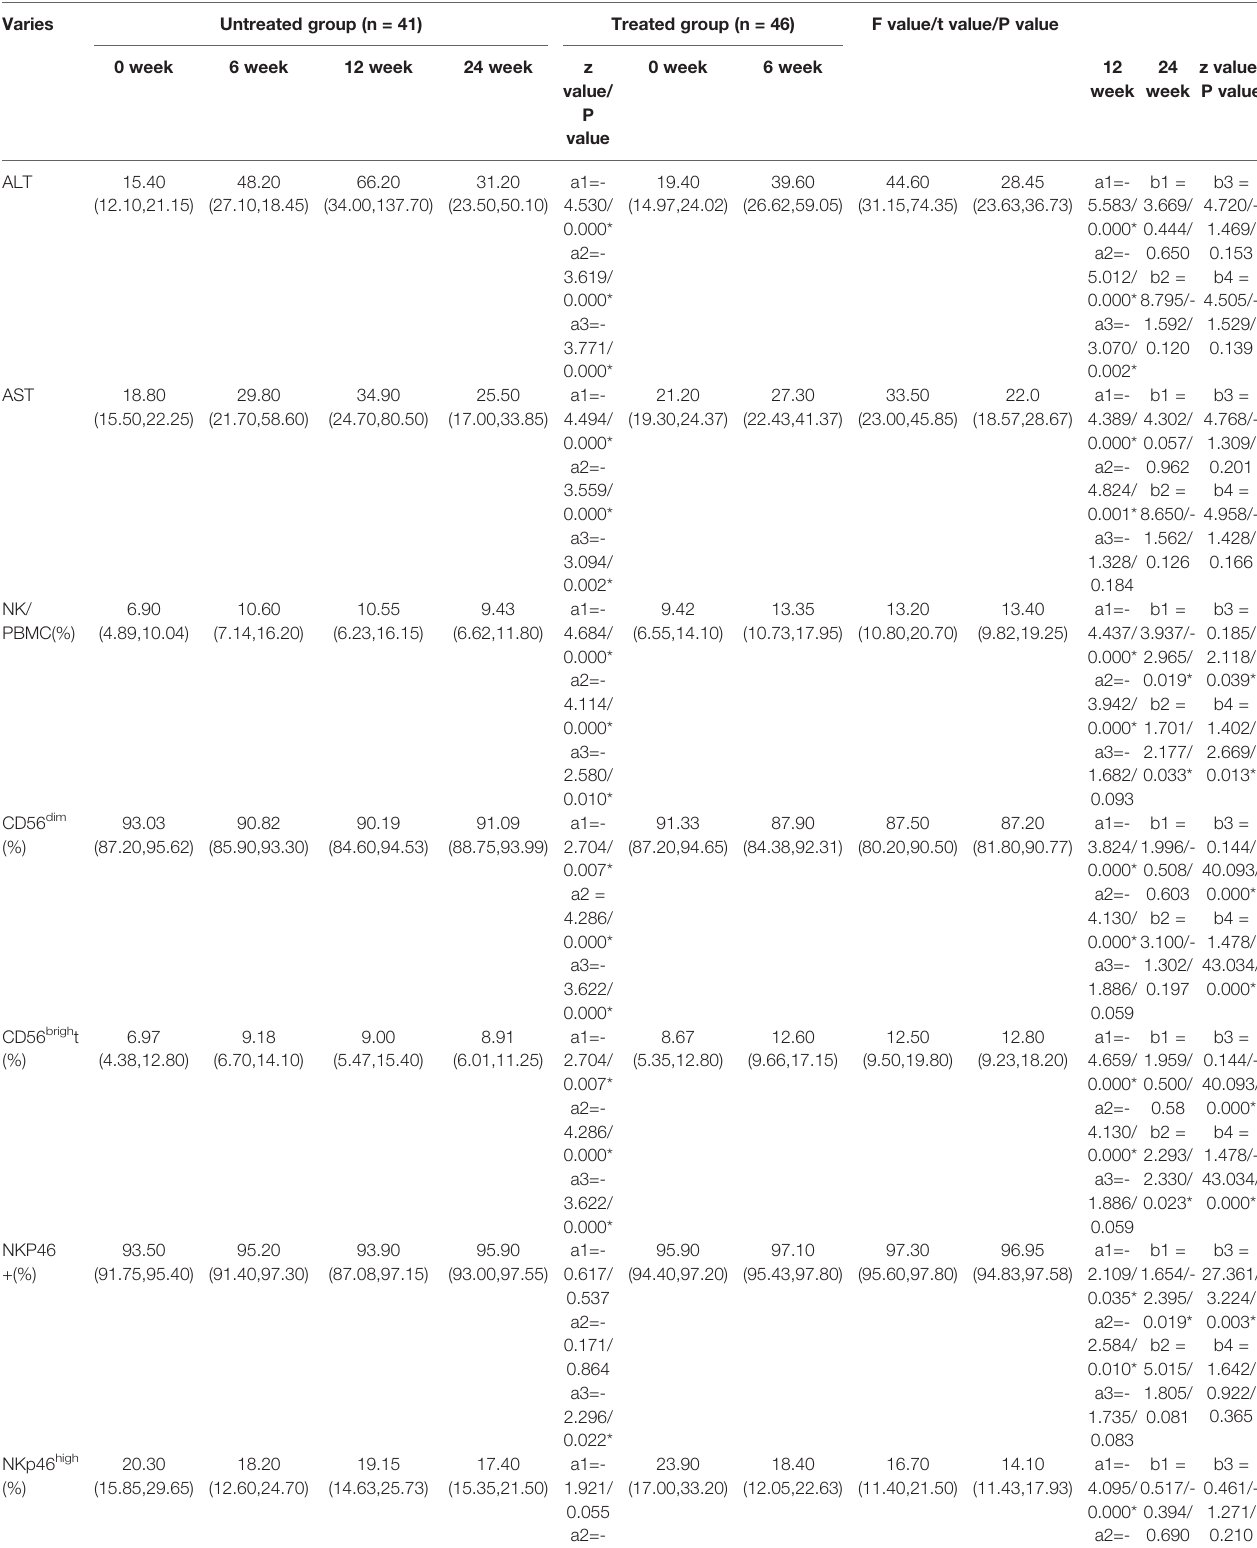
TABLE 2 | Changes in NK cell frequency and functional molecular expression after delivery in both pregnant groups.